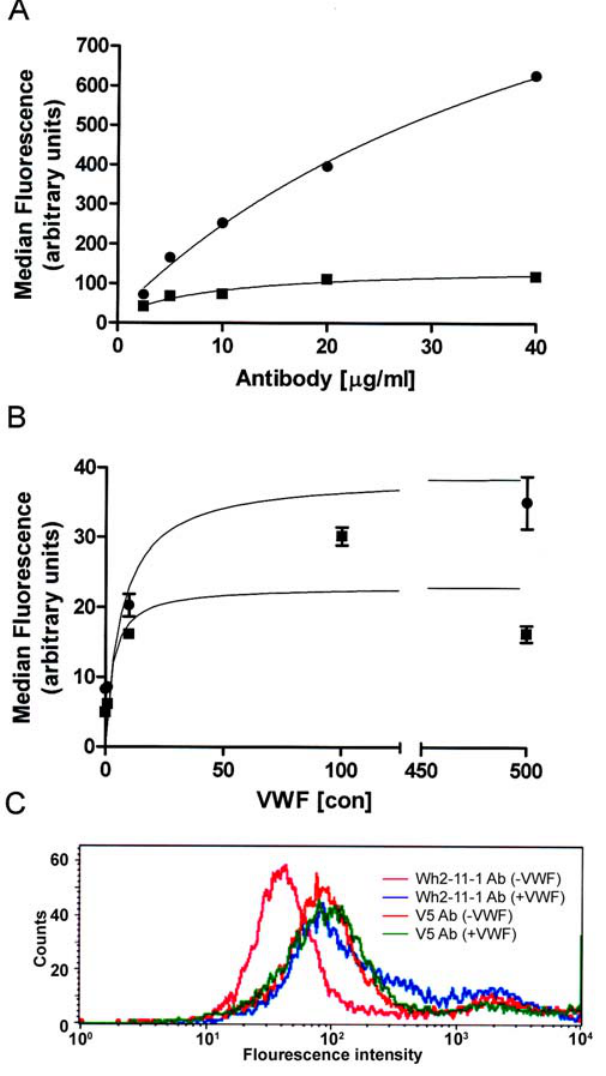
Figure 3. VWF increases the immunoreactivity of anti- ADAMTS13 antibody Wh2-11-1. (A) Serial dilutions of the mAb N Wh2-11-1 were allowed to bind to ADAMTS13 from human embryonic N ) of 100-500 m l cells (HEK293 cells) in the absence ( & ) or presence ( ) of the mAb Wh2-11-1 from VWF stock. (B) Either 1 m g ( & ) or 5 m g ( were allowed to bind ADAMTS13 in the presence of increasing concentrations of VWF. The binding of the antibody in both experiments was monitored using flow cytometry and the data plotted using the curve-fitting software Graphpad Prism. (C) The binding of the mAb Wh2-11-1 was compared to that of the anti-V5 antibody in the absence or presence of VWF using flow cytometry. The histograms represent: Wh2-11-1 alone (red), Wh2-11-1 in the presence of VWF (green), anti-V5 alone (pink) and anti-V5 in the presence of VWF (blue). The figures represent data from one of three independent experiments.